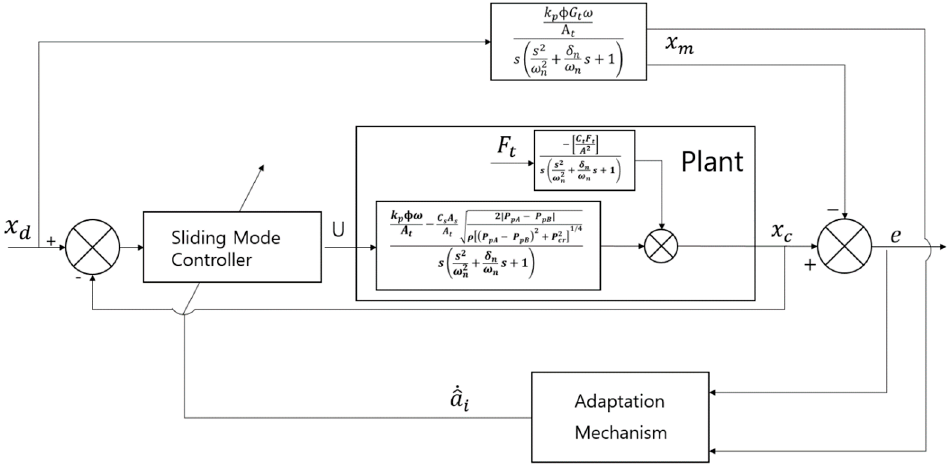
Processes 2019 , 7 , 389 Figure 4. Adaptive sliding mode control scheme. Figure 4. Adaptive sliding mode control scheme.